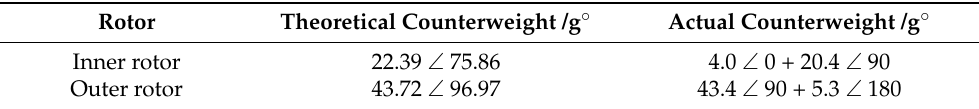
Table 4. The theoretical counterweights and the actual